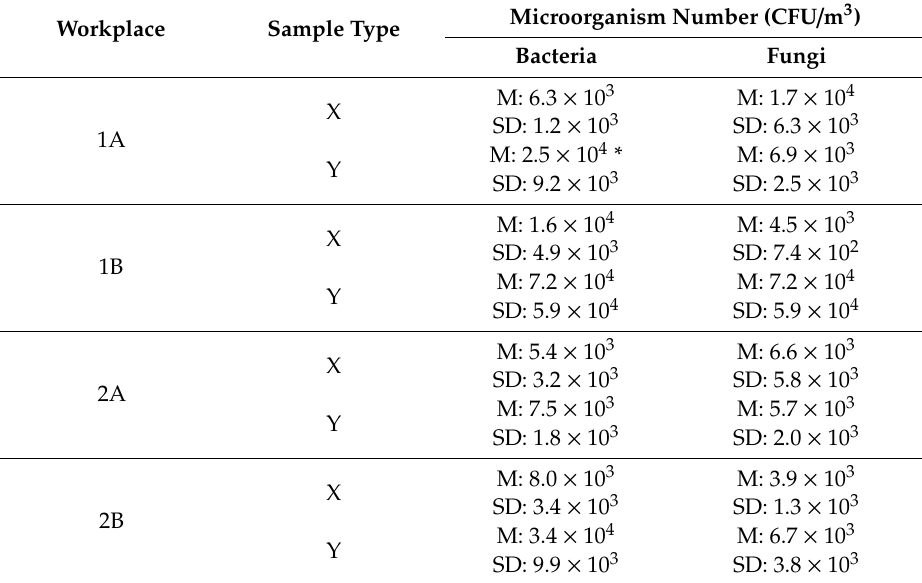
Table 6. Microbiological contamination of air at workplaces. Microorganism Number (CFU / m 3 ) Workplace Sample Type Bacteria